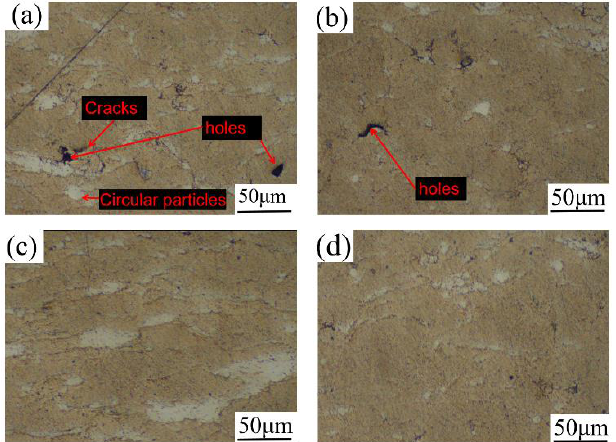
Figure 4. Microstructure of coating sections at different spraying temperatures: ( a ) 400 °C, ( b ) 450 °C, ( c ) 500 °C, ( d ) 550 °C.